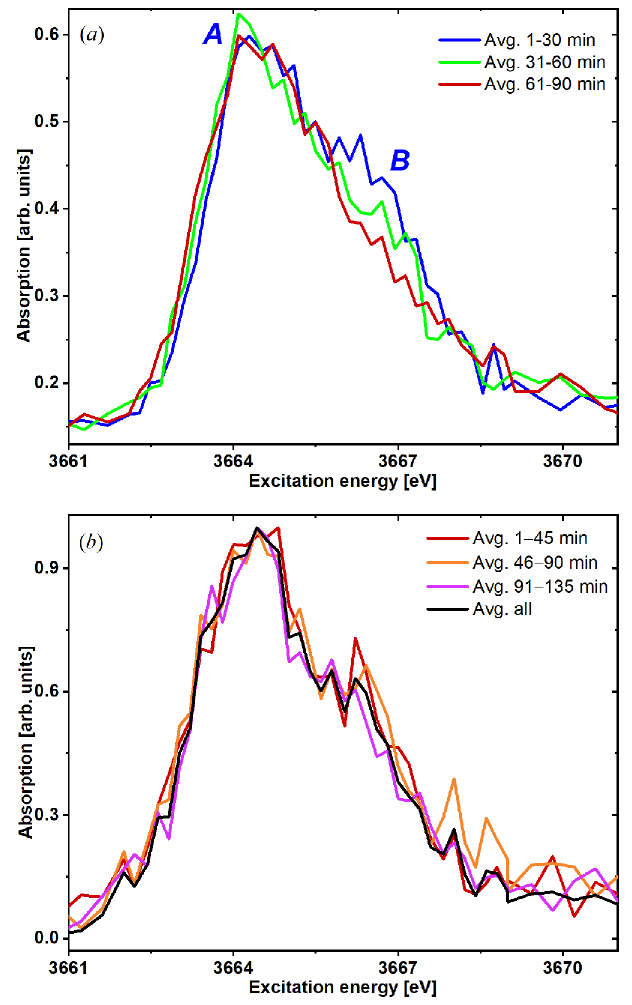
Figure 6 ( a ) Gradual change of Np M 5 -edge HR-XANES spectra of a sample with 83 (cid:7) 2 p.p.m. Np sorbed on illite ( cf . Section 6 for sample details) at 300.0 (cid:7) 1.5 K. Changes in the shoulder denoted as feature B are visible with irradiation time. ( b ) At cryogenic conditions (141.2 (cid:7) 1.5 K), no significant changes of the spectra are discernible within the noise